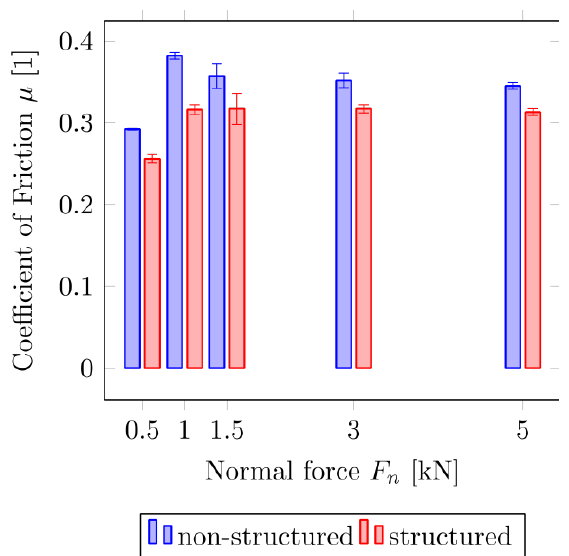
Figure 7. Results of the friction measurement on the tribometer for the non-structured (blue) and structured (red) samples. Error bars show standard deviations of the means measured for 3 individual pins.